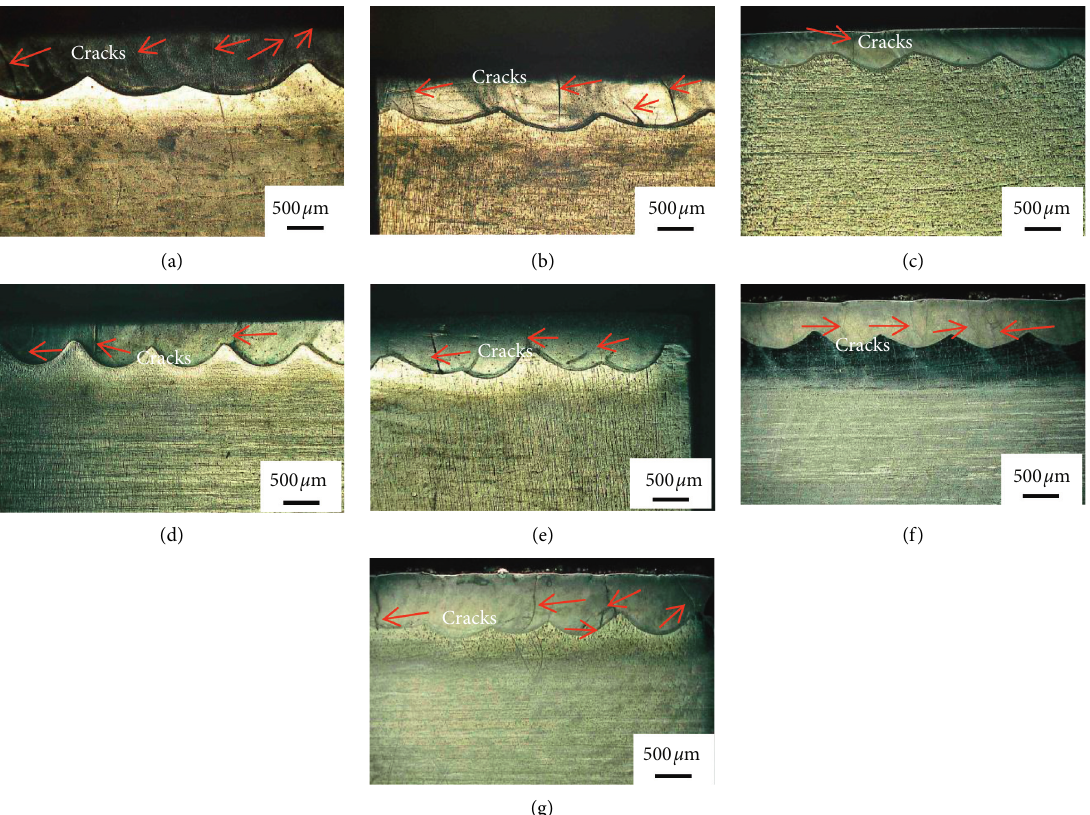
Figure 2: The macromorphology of the coatings with different CeO 2 contents: (a) 0%, (b) 1%, (c) 2%, (d) 3%, (e) 4%, (f) 5%, and (g)